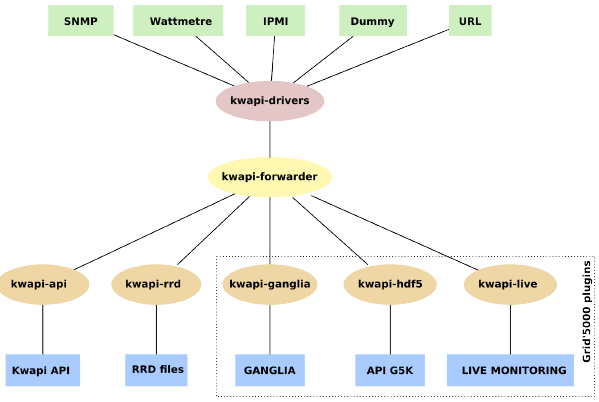
Figure 1: Architecture of